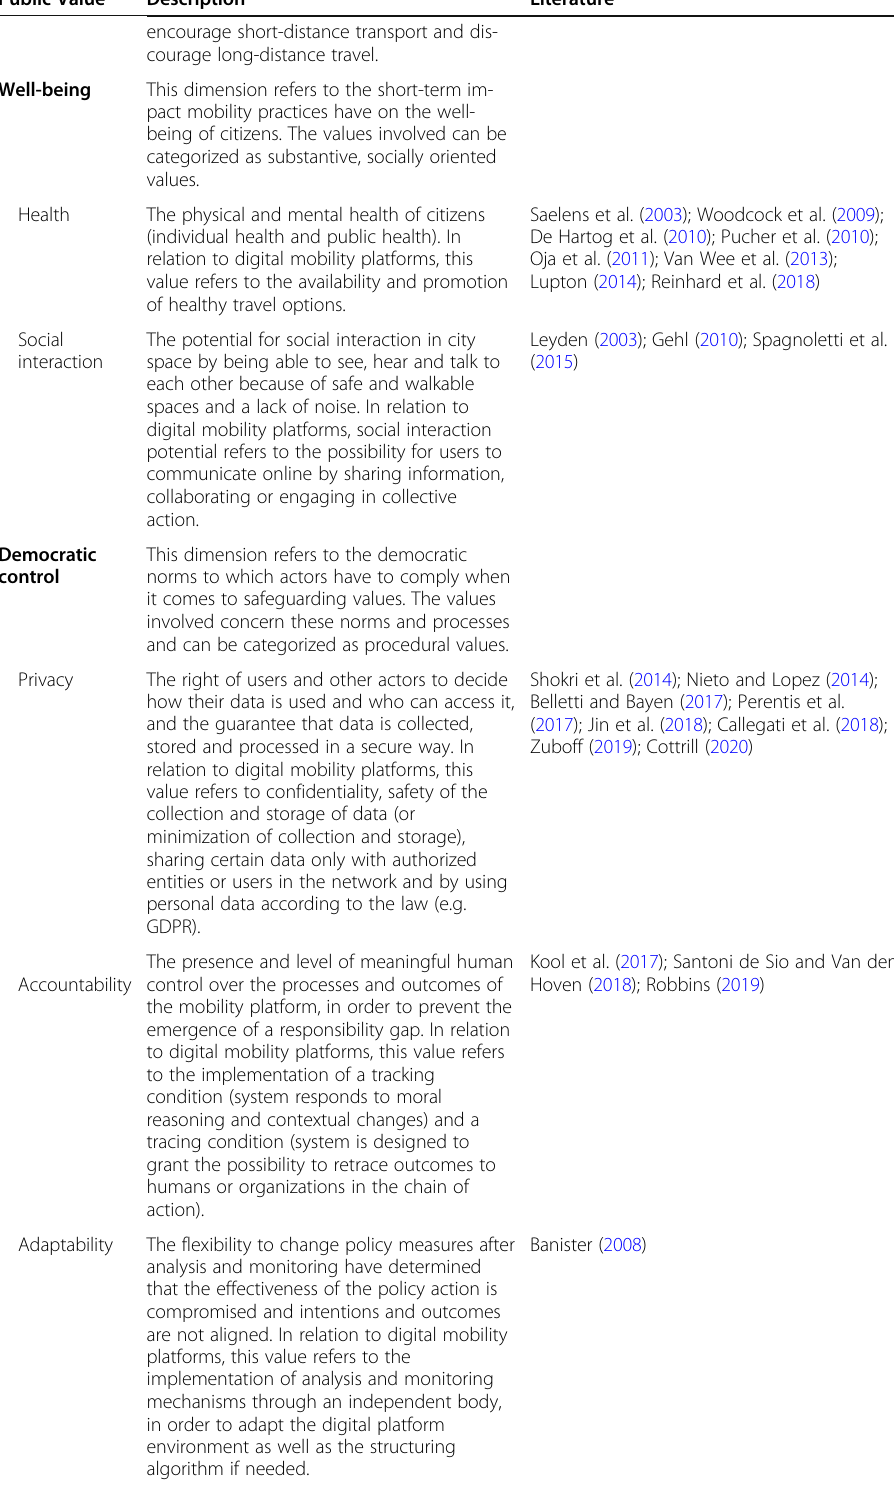
Table 3 The assessment framework with the four theoretical dimensions, value descriptions